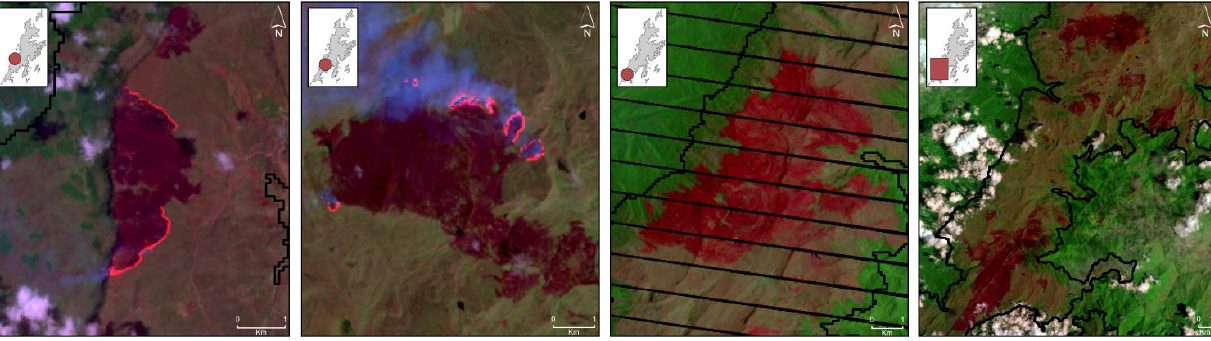
Figure 11. Landsat image showing multiple scars and active fires in the paramo ecosystems (data base: Landsat TM/ETM; the black line indicates the study area